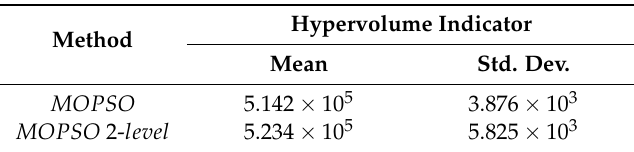
Figure 10. Convergence of the proposed 2-level MOPSO vs. standard MOPSO in a supersonic climb path optimization problem, using a population of 20 particles; results are averaged from 10 two-objective optimization runs. Iteration counts for the two-level method have been shifted to account for the computational cost of the low-level optimization run. The hypervolume indicator quantifies the part of the objective space (up to a user-defined “nadir” point) dominated by the Pareto front. Higher indicator values correspond to better-placed and/or better-populated fronts. Table 3. Convergence of the proposed 2-level MOPSO vs. standard MOPSO after 100 iterations; Statistics have been derived from 10 optimization runs for each